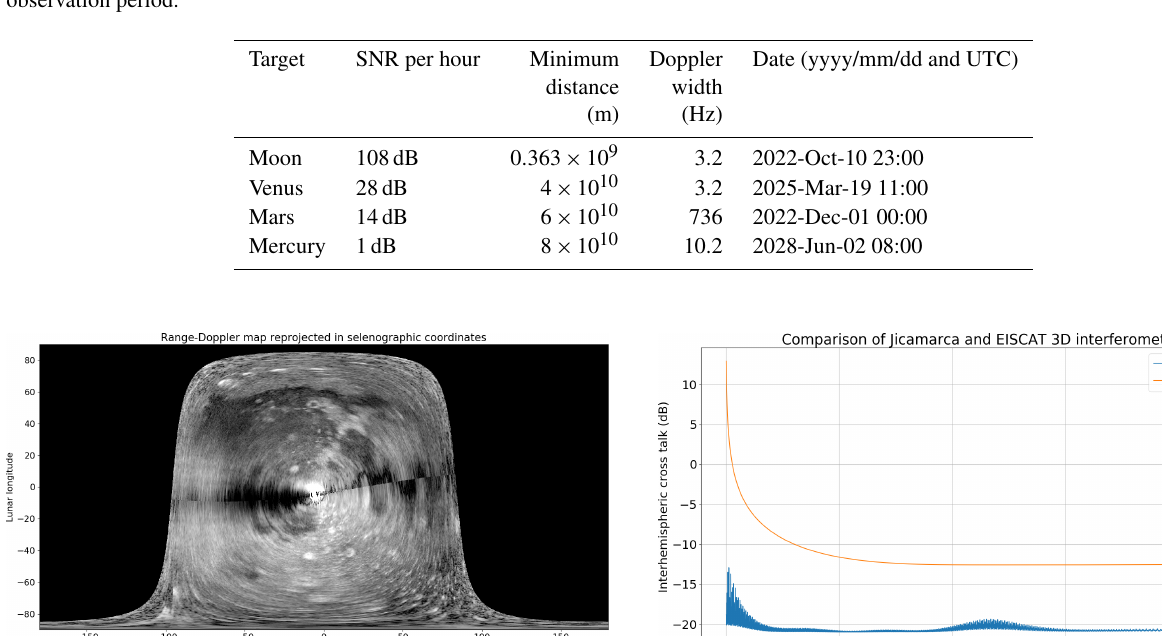
Table 1. Achievable SNR for hour-long observations of the terrestrial planets and the Moon. The date at which the target has the best SNR is shown (in yyyy/mm/dd and universal coordinated time – UTC), along with the Doppler width and approximate distance during the observation period.